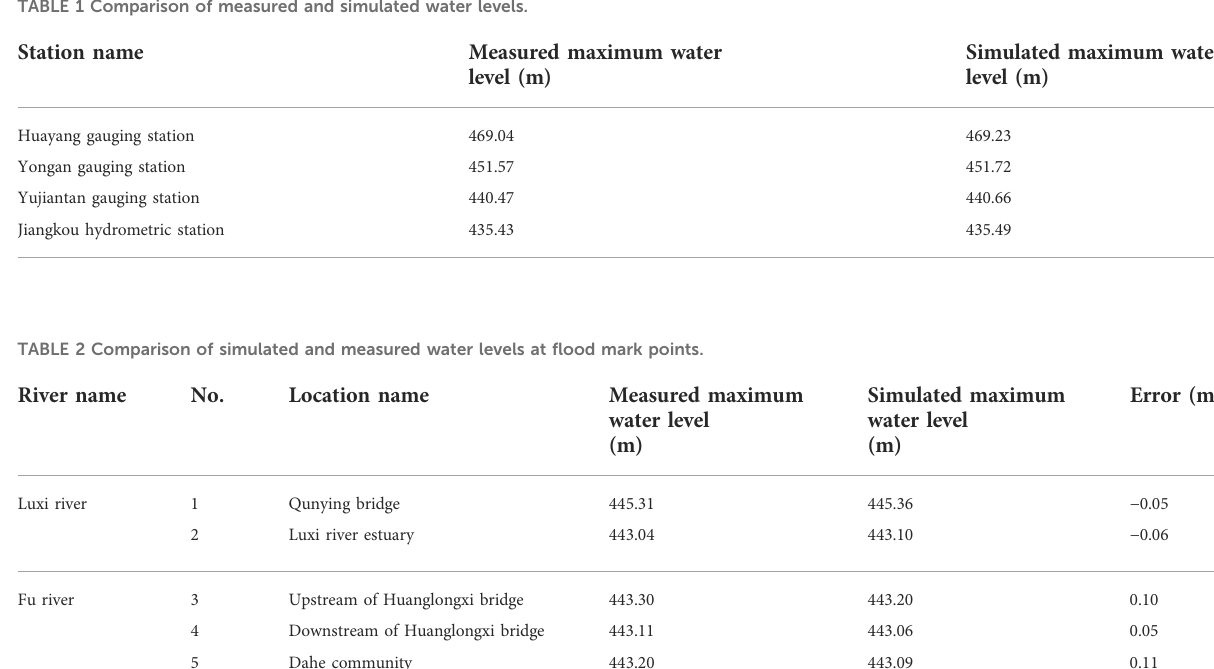
TABLE 1 Comparison of measured and simulated water